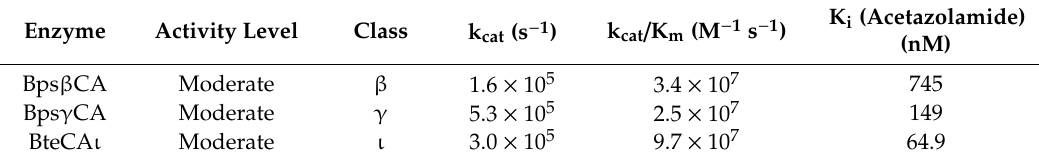
Table 1. Kinetic parameters for the CO 2 hydration reaction catalyzed by the β - and γ -CAs from B. pseudomallei and ι -CA from B. territorii measured at 20 ◦ C, pH 8.3 in 20 mM TRIS bu ff er, and 20 mM NaClO 4 [20,21,35]. Acetazolamide inhibition data are also